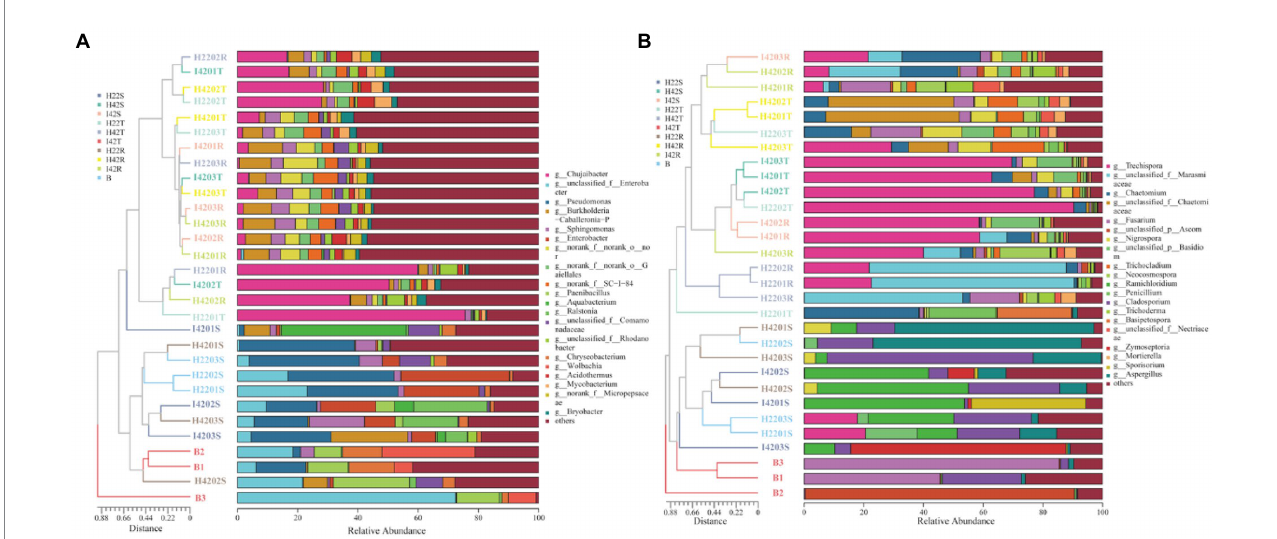
FIGURE 2 Figure of horizontal abundance of microbiome genera, with clustering trees drawn by bray weighting algorithm on the left and icons in descending order of richness on the right. (A) Genus level abundance map of bacterial microbiota. (B) Genus level abundance map of fungal